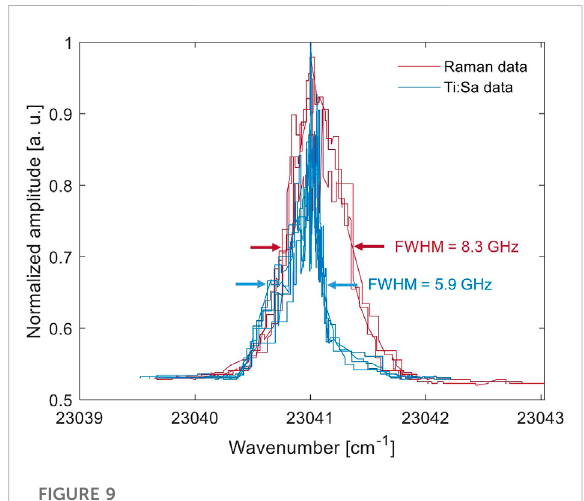
FIGURE 8 Normalized values of the measured ion current for the Raman and the Ti:Sa lasers depending on the output power of each laser along with their corresponding fi ts and the obtained saturation point.